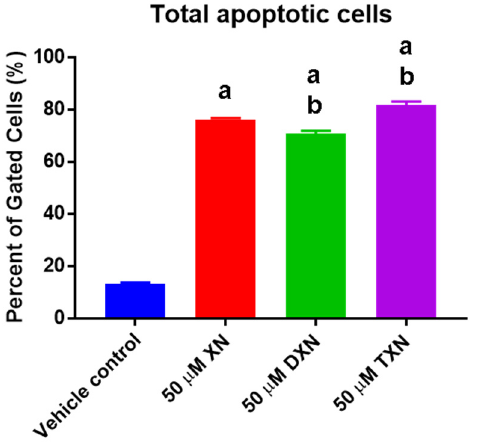
Figure 4. Total percentage of apoptotic and dead cells. Values are mean ± SD, n = 9 for each condition. The letter “a” indicates a statistically significant difference from vehicle control, the letter “b” indicates a statistically significant difference from 50 µ M XN ( p < 0.05). Statistical analysis was performed using one-way ANOVA with a Sidak’s post hoc test.